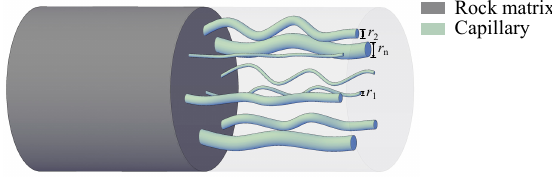
Figure 2. Diagram of capillary model.